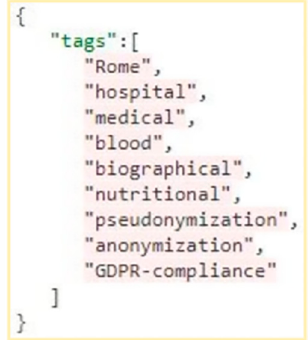
Figure 6. Virtual Data Container (VDC) Blueprint tags.